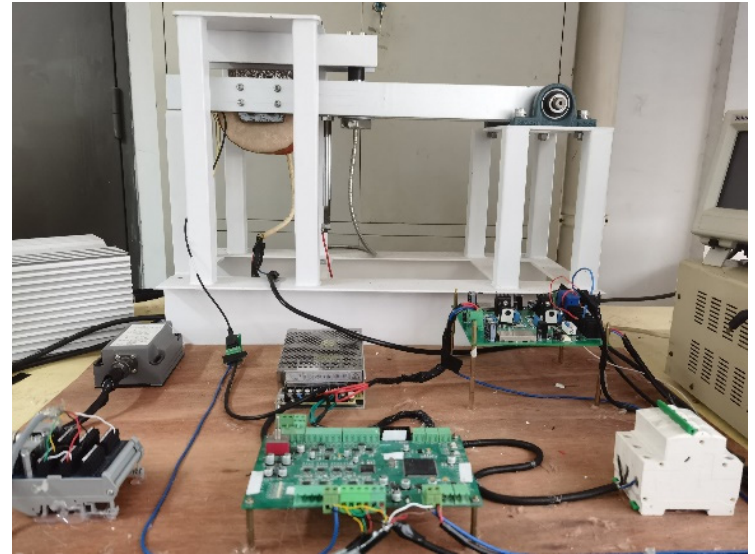
Figure 4. Experimental device.